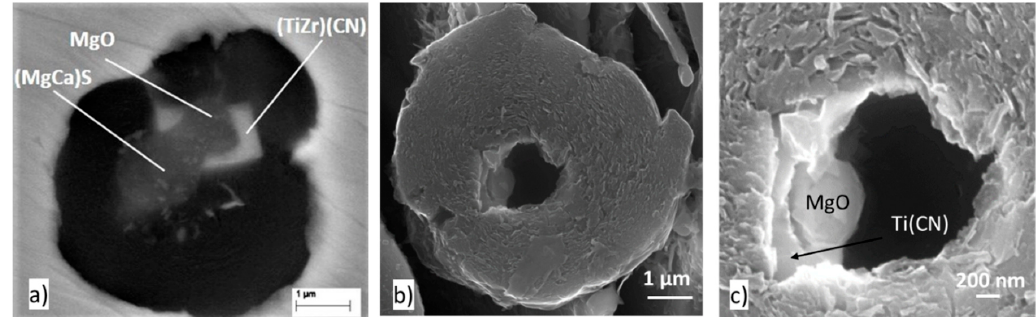
Figure 25. Nuclei in imperfect graphite spheroids from irons with 0.03% Ti quenched from the solidification interval: ( a ) Effect of a (TiZr)(CN) inclusion, reproduced from [85] with permission from American Foundry Soc.; ( b ) effect of a Ti(CN) inclusion; ( c ) magnification of image in ( b ).